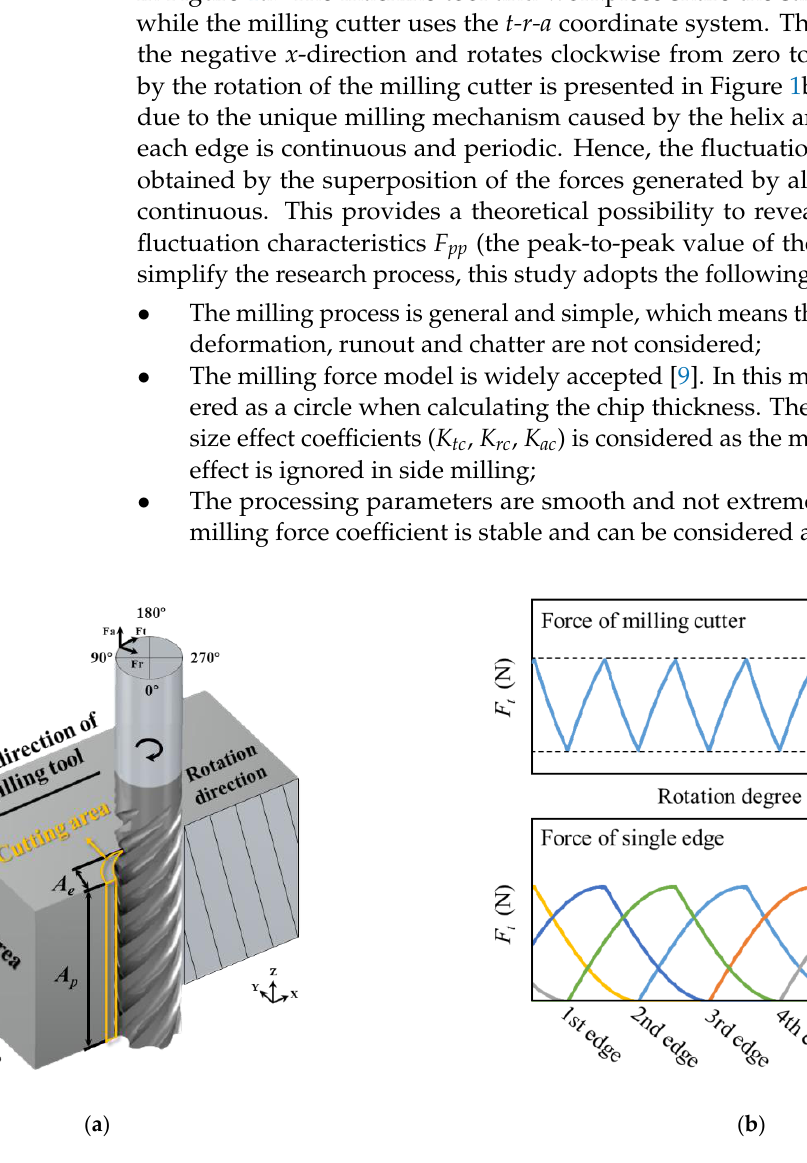
Figure 1. Milling geometry and mechanism of a helical-edge cutter: ( a ) process of down milling and ( b ) the distribution of milling forces.